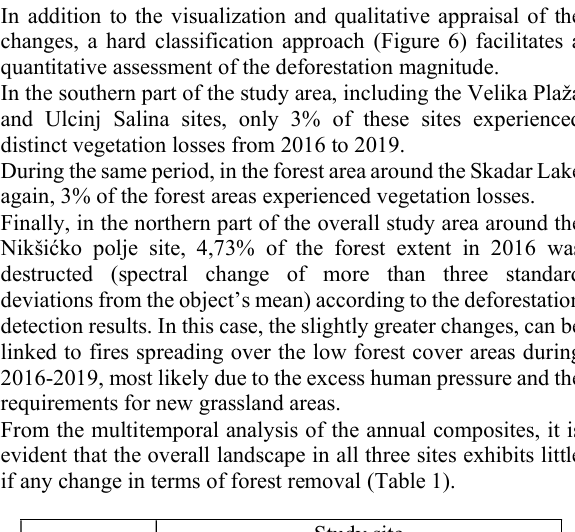
Figure 6. Deforestation detection based on the bi-temporal analysis of two single scenes acquired on 09-07-2016 and 15- 07-2015. A hard classification procedure is applied to delineate areas exhibiting forest disturbance